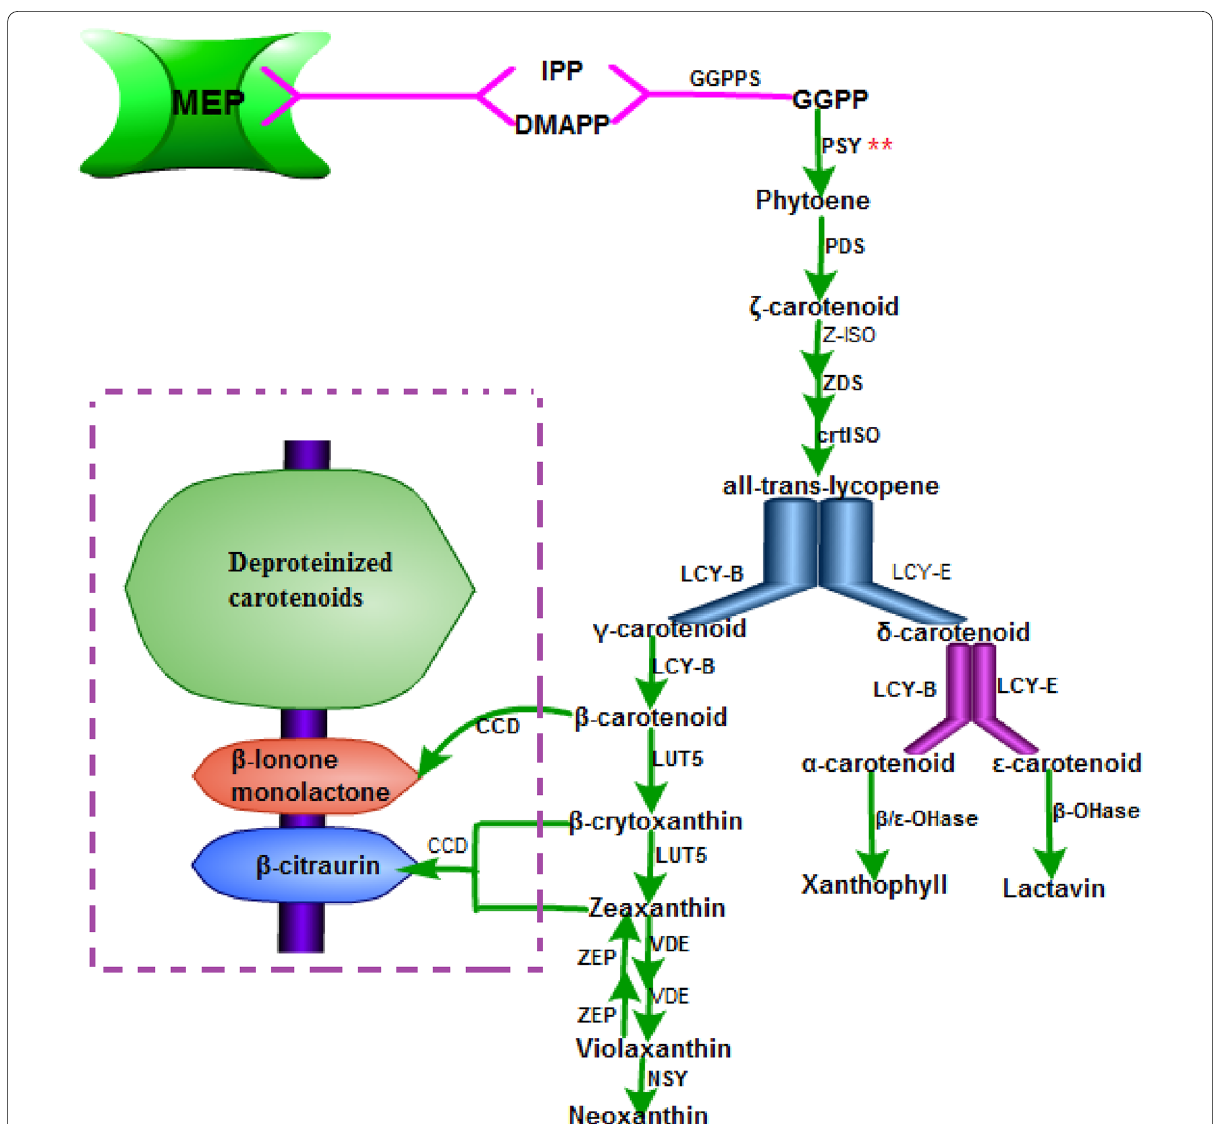
Fig. 2 Synthetic pathway of carotenoids (“**”: the key enzymes or genes that regulate carotenoid synthesis, and the dotted box is the degradation of carotenoids. The related enzymes and genes are shown in Table